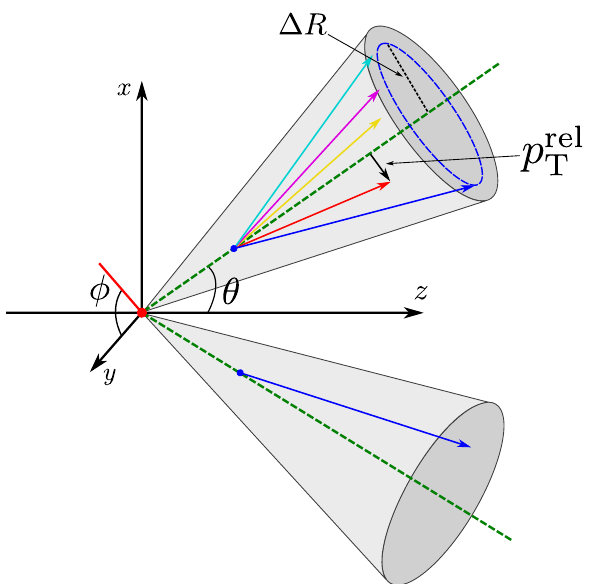
Figure 1. Sketch representing possible jet tagging methods. In the exclusive method the informa- tion comes from a particle, e.g. the muon, whose charge is correlated to the b hadron (lower jet); in the inclusive method, the information is extracted from the jet constituents (upper jet). The magnitude of the particle momentum transverse to the jet axis is labelled as p rel